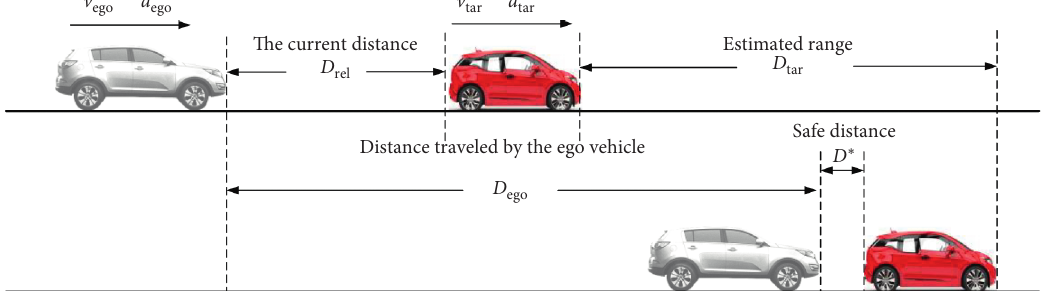
Figure 9: The ideal braking model based on DTTC.